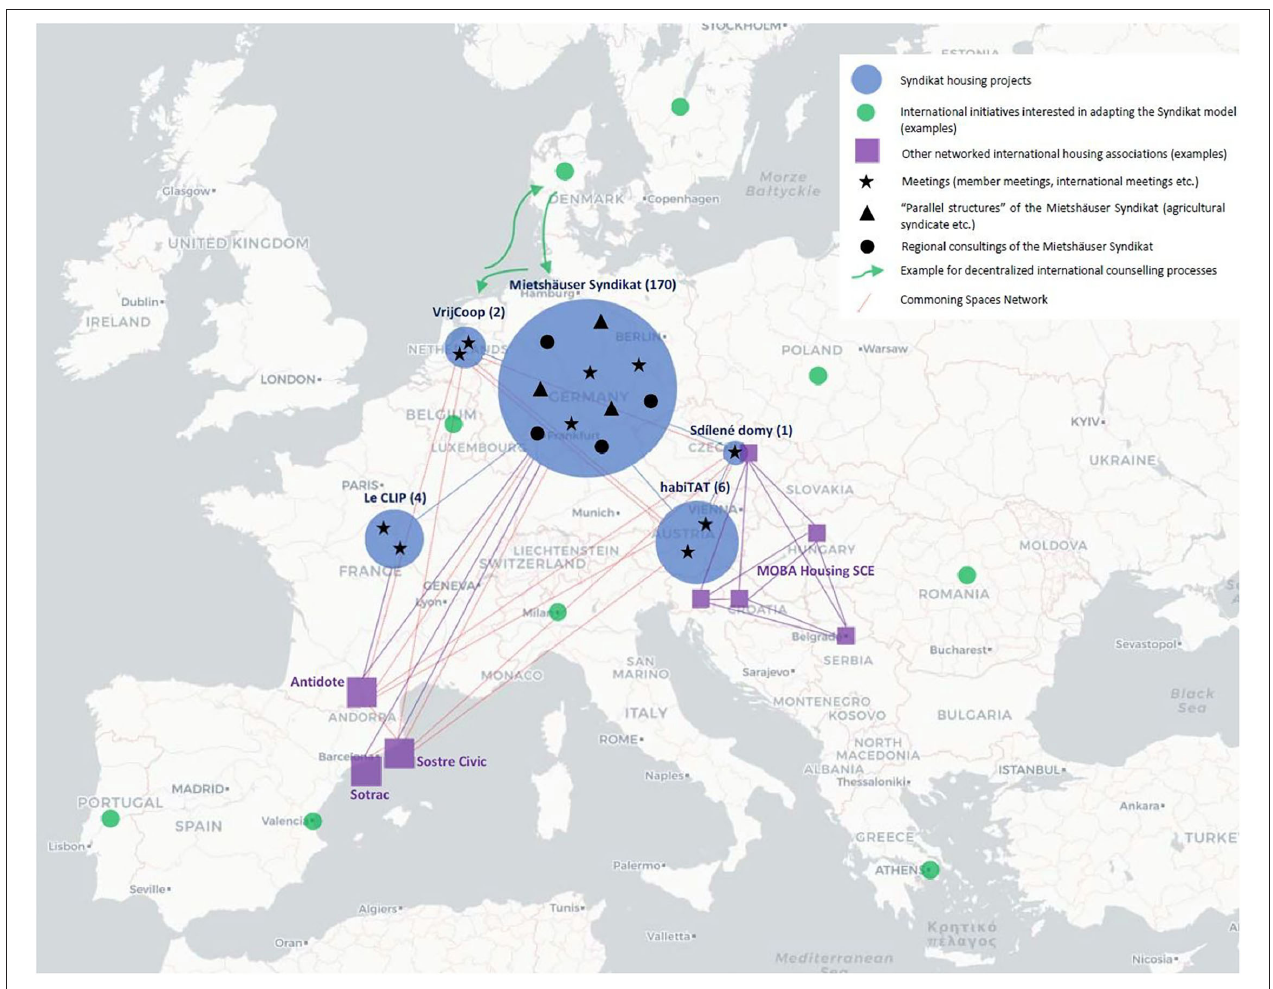
FIGURE 1 | Translocal mobilization of the Syndikat model until 2021. Source: author’s own; design: Tim